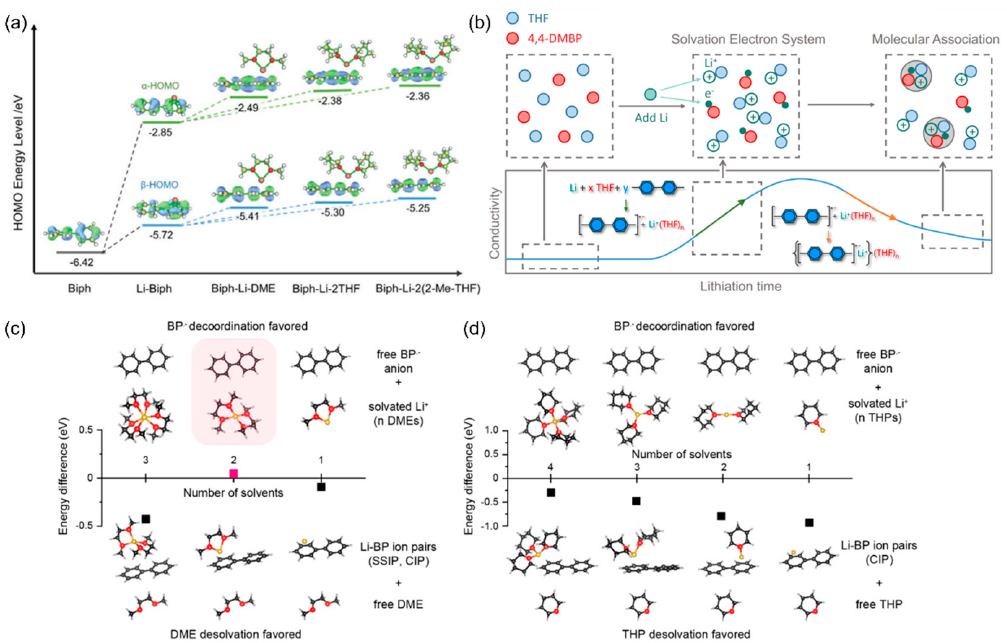
Figure 5. ( a ) Geometrical configurations and HOMO energies of the Li–Biph(BP) in DME, THF, and 2-Me-THF. Reproduced with permission from ref. [55]. Copyright 2021, Wiley-VCH. ( b ) Schematic illustration showing the formation and evolution of lithium radical anions and the corresponding conductivity change in the solution during lithiation. Reproduced with permission from ref. [54]. Copyright 2021, ACS Publications. Prediction of Li-ion desolvation paths by evaluating the thermo- dynamic stability of possible ion-pair intermediates ( c ) in the strong solvent DME and ( d ) in the weak solvent THP using DFT calculations. Reproduced with permission from ref. [56]. Copyright